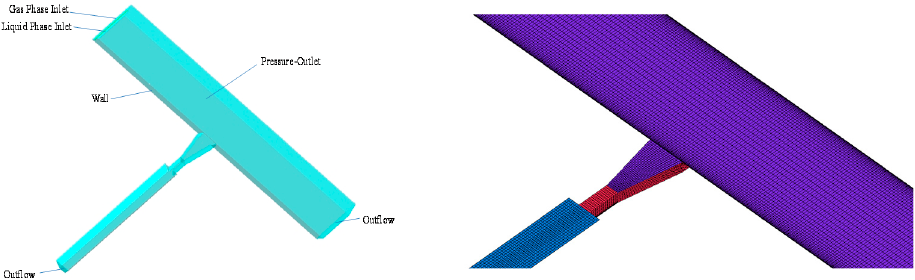
Figure 5. Boundary conditions for the setting and meshing results of the numerical simulation.